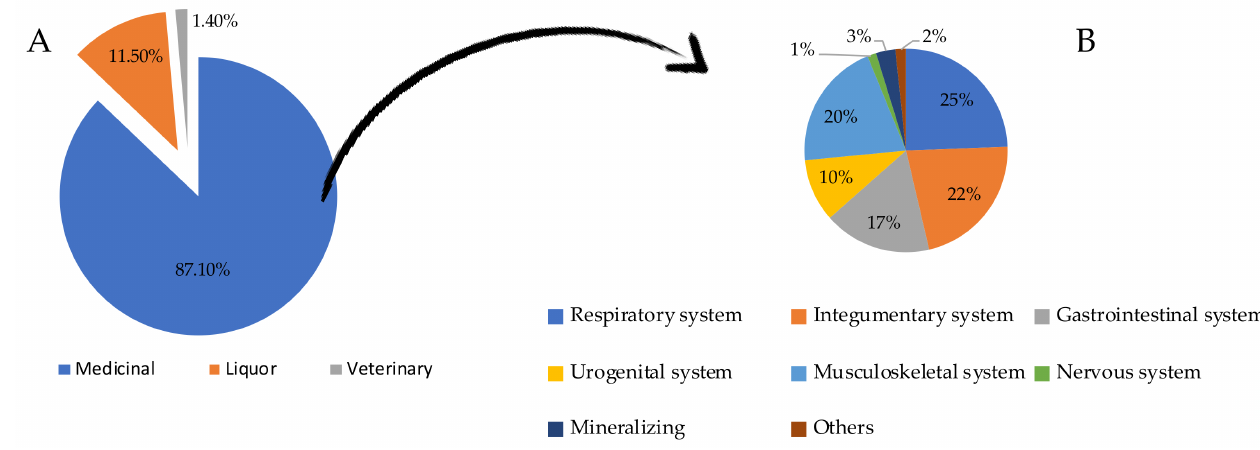
Figure 2. ( A ) Percentage of citations collected during the interviews grouped for categories of use, and ( B ) main applications of the medicinal